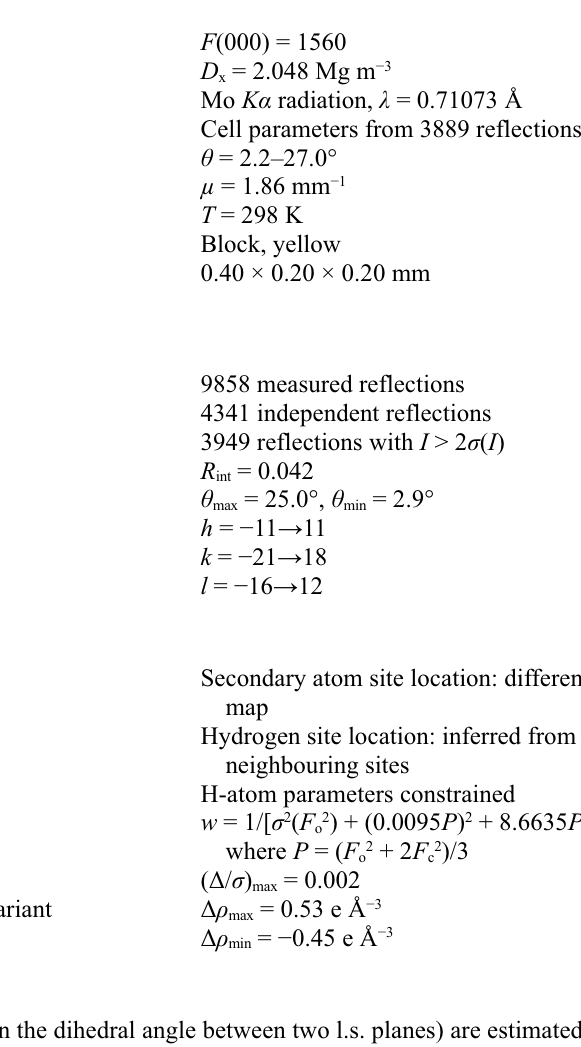
Figure 2 The packing in (I), with hydrogen bonds indicated by dashed